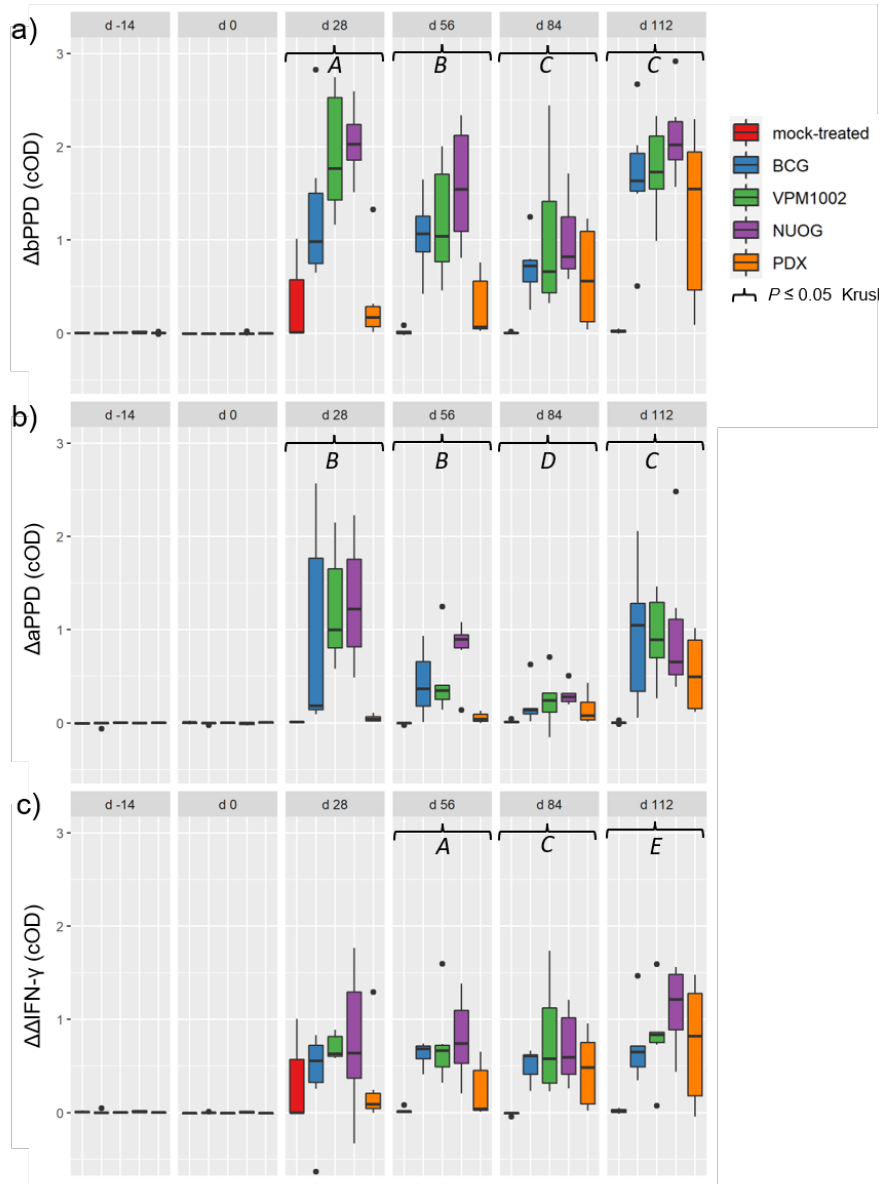
Figure 5. Antigen-specific interferon gamma (IFN- γ) release in whole blood samples of goats, subcutaneously vaccinated or mock-treated, upon in vitro stimulation with bovine (bPPD) and avian purified protein derivative (aPPD). Results are presented as Δ optical density of enzyme-linked immunosorbent assay (ELISA) measurements after stimulation of blood samples with bPPD ( a ), with aPPD ( b ), and as the difference between data obtained after stimulation with bPPD and aPPD ( c ), as described in Materials and Methods. ( A ) Statistically significant differences between the mock- treated group and the BCG-, VPM1002-, and NUOG-vaccinated groups, respectively. PDX-vaccinated animals significantly differed from the other three vaccinated groups, but not from the mock-treated group. ( B ) Statistically significant differences between the mock-treated group and all vaccinated groups, respectively, and between the BCG- and the NUOG-vaccinated group when compared to the PDX group. ( C ) Statistically significant differences between each of the vaccinated groups and the mock-treated group. ( D ) Statistically significant differences between the BCG-, NUOG-, and PDX-vaccinated, but not the VPM1002-vaccinated, groups and the mock-treated group. ( E ) Statistically significant differences between the BCG-, VPM1002-, and NUOG-vaccinated, but not PDX-vaccinated, animals and the mock-treated group.